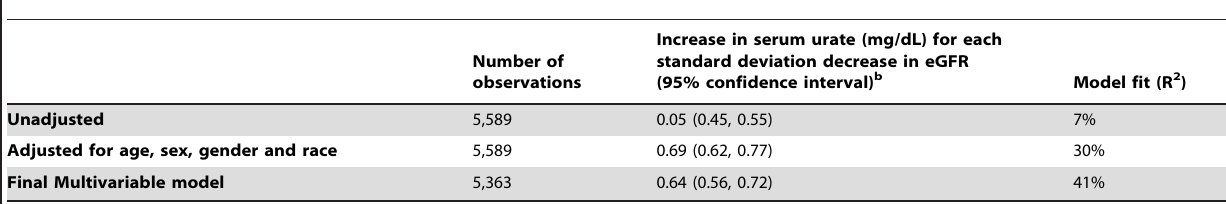
Table 7. Results of ordinary least squared regression analyses of the relationship between serum urate and eFGR. a